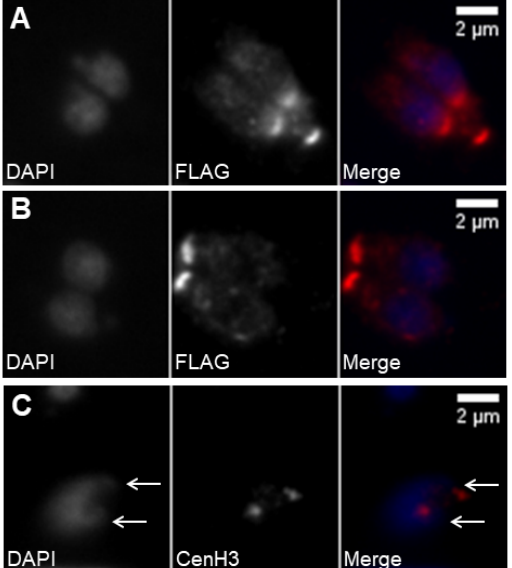
Figure 5. Daughter cell assembly involves DNA duplication and segregation. ( A , B ) Immunofluo- rescence of intracellular tachyzoites stably expressing a FLAG-MORN1 recombinant protein cou- pled to the MORN1 promoter region. The recombinant protein is stained with anti-FLAG. DNA is stained with DAPI. The top panel ( A ) shows fully segregated DNA and the newly formed daughter cells’ basal polar rings while the mother cell’s basal polar ring is still present. The bottom panel ( B ) shows two fully mature, recently formed tachyzoites, each presenting one basal polar ring. ( C ) Im- munofluorescence of an intracellular tachyzoite that has suffered DNA duplication, as marked by the presence of duplicated centromeres. The nucleus shows two apical protrusions (white arrows) indicating the centrocones. The centromeres are identified by staining with anti-CenH3. DNA is stained with DAPI. The scale bars represent 2 µ